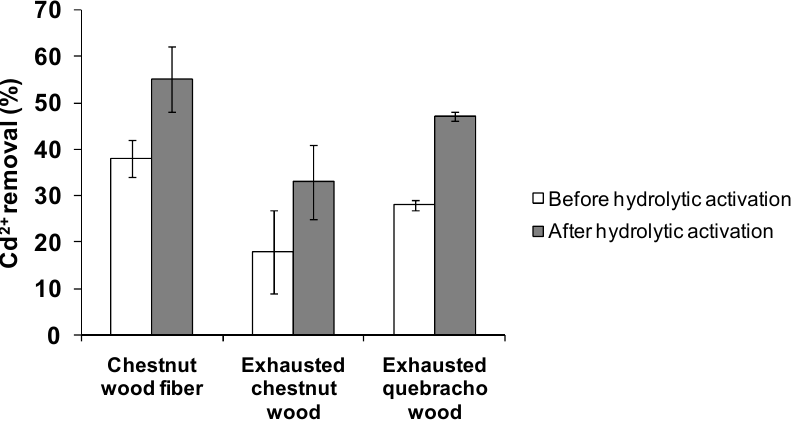
Figure 9. Cd 2 + removal by exhausted woods before and after hydrolytic activation. Reported are the mean ± SD values of at least three experiments.